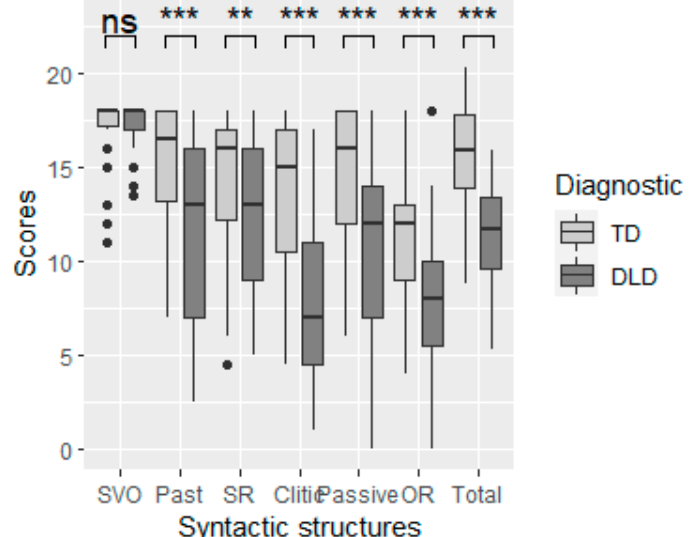
Figure 1. Comparisons between children with TD and DLD for the DA of morphosyntax. ns: non-significant; ** p < 0.01; *** p < 0.001.